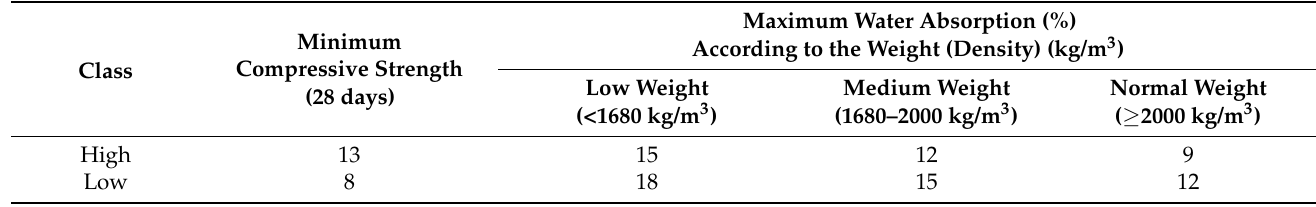
Table 4. Compressive strength and water absorption requirements, and classification by weight for structural masonry concrete units, according to NTC 4026 [48] (equivalent to ASTM C90 [49]) and NSR-10 [50] title E.